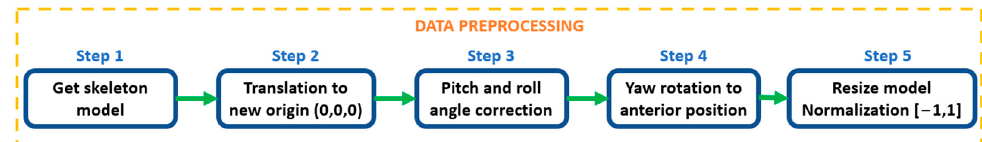
Figure 2. General methodology for estimating an on-line MET value with an RNN.